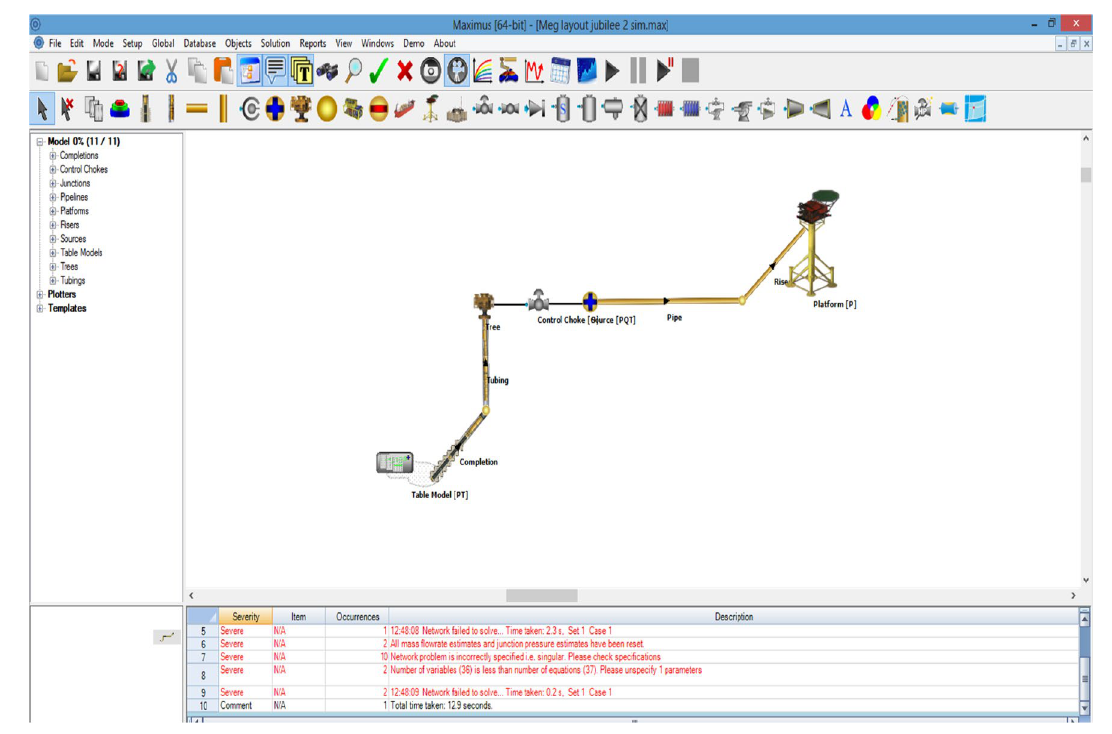
Fig. 11 Simulation showing that MEG crashed at 150 gal